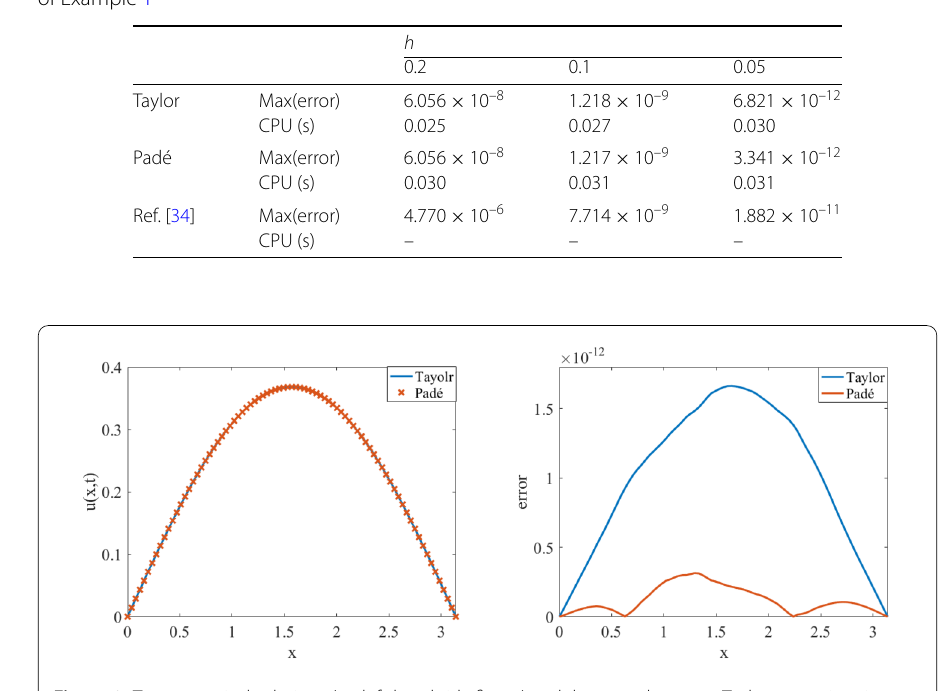
Figure 9 Two numerical solutions (on left-hand side figure) and the errors between Taylor approximation and Padé approximation (on right-hand side figure) with N = 81 for Example